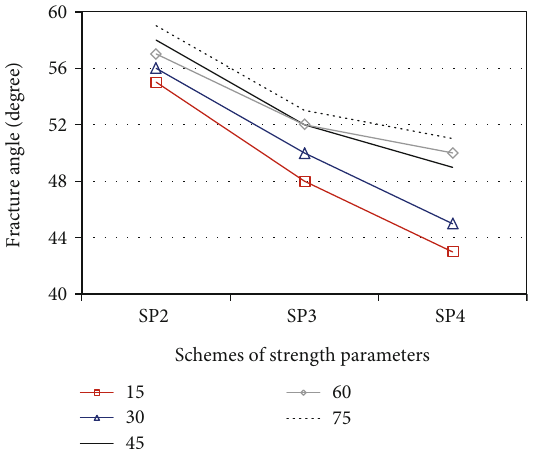
Figure 8: Evolution of fracture angles.